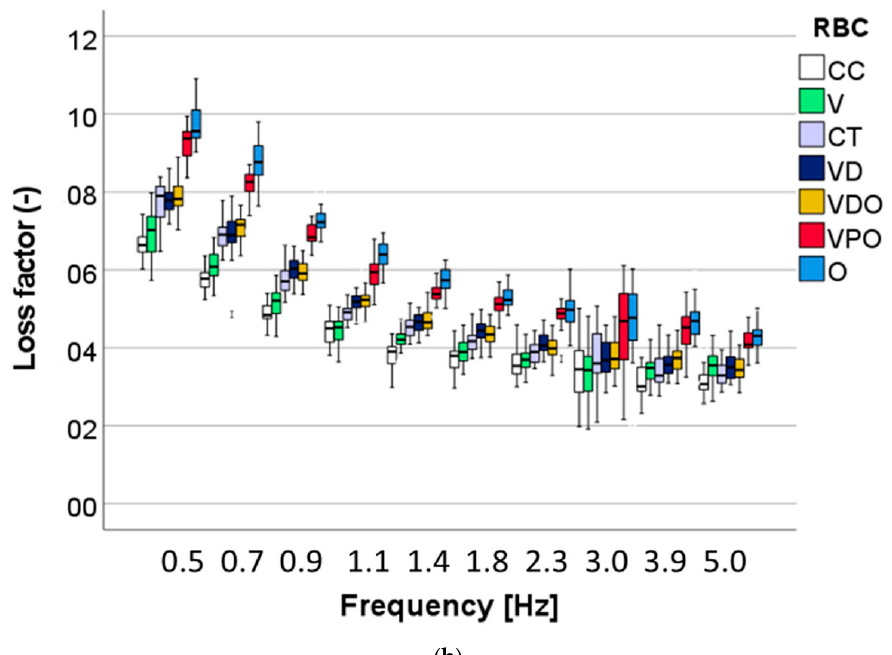
Figure 11. Viscoelastic material behavior: Variation of the loss factor (tan delta) as a function of material and frequency in ( a ) unaged and ( b ) after 6 months’ immersion in artificial saliva.